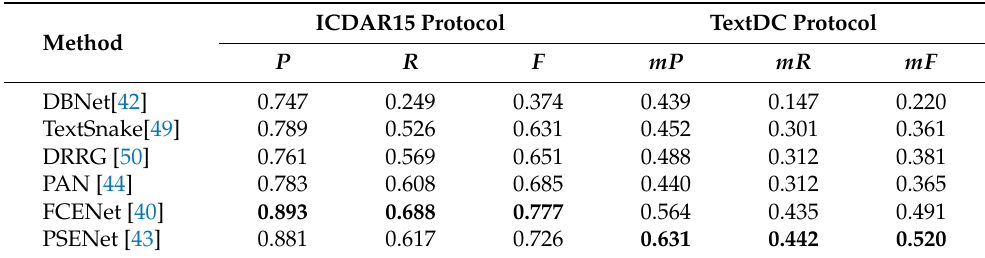
Table 2. Comparison results of the state-of-the-art text detectors on the established Text3C dataset, evaluated with the ICDAR15 protocols [7], and the proposed TextDC protocols without category constraints. Bold indicates the best